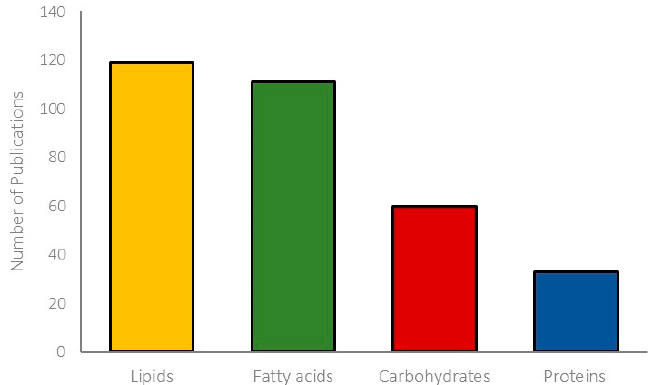
Figure 1. Platforms used in the search for scientific articles for review, date of chosen scientific arti- cles, and primary metabolites revised.